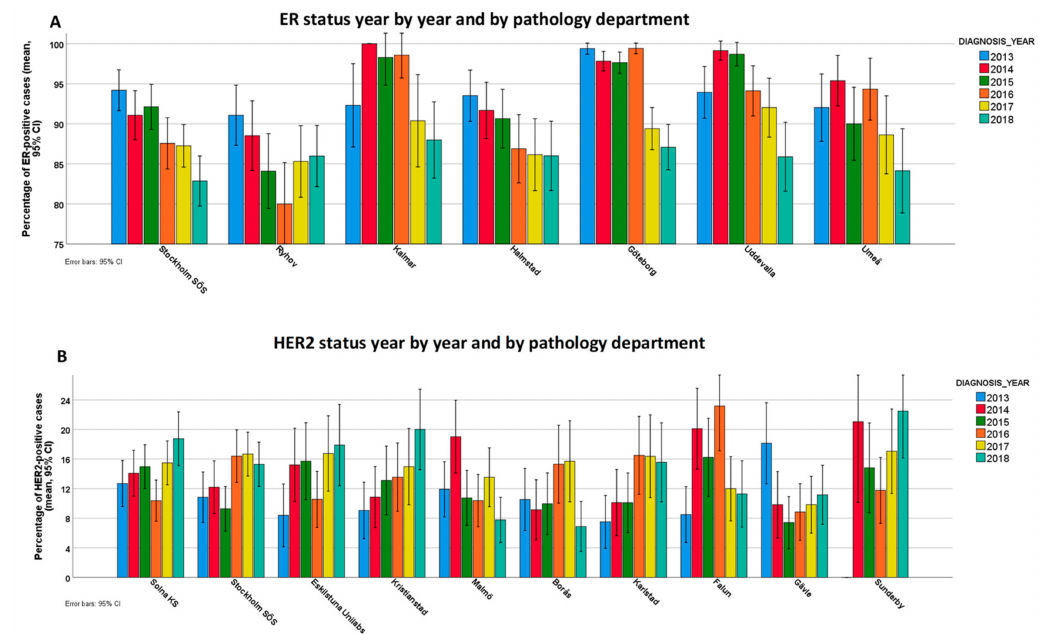
Figure 2. Intra-lab variability for ER ( A ) and human epidermal growth-factor receptor 2 (HER2) ( B ) status among pathology departments. Only laboratories showing statistically significant differences are shown. Please refer to Figure S1 to see all the